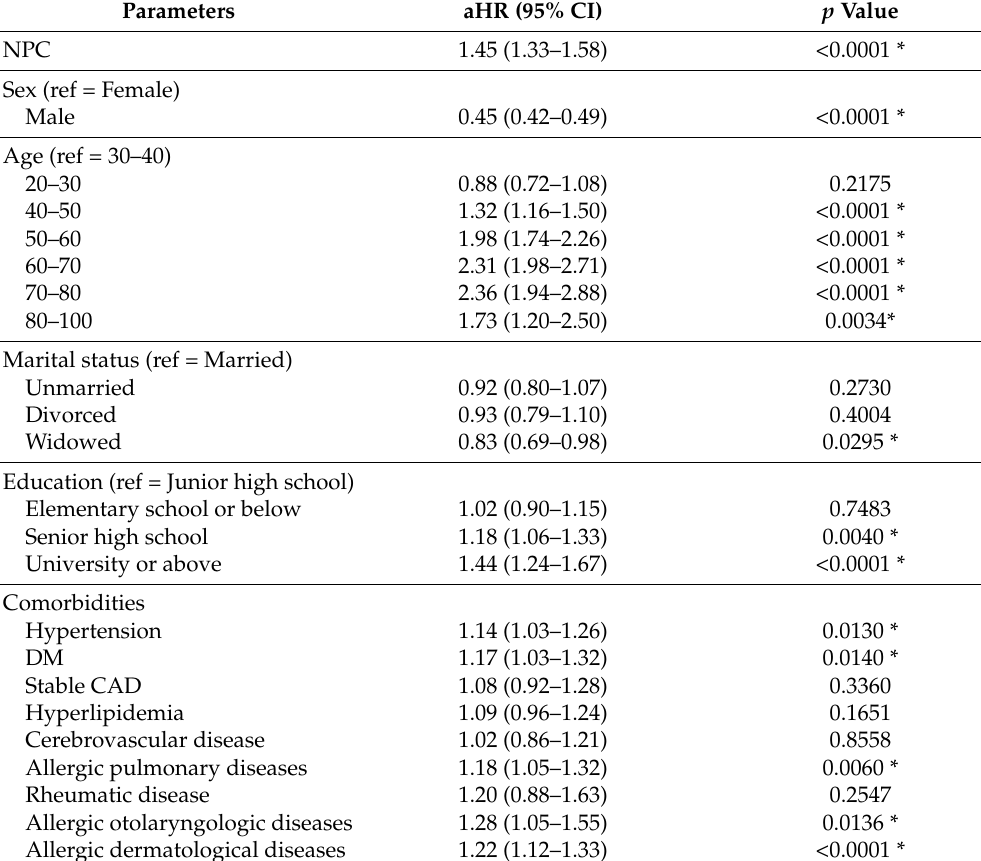
Table 3. Cox regression for estimating the hazard ratio of dry-eye